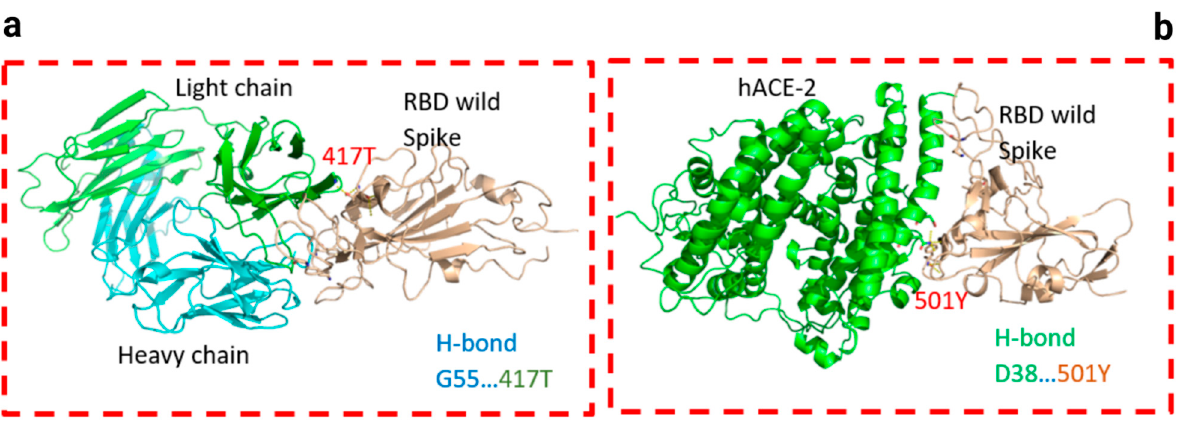
Figure 6. Docking structures of the interaction of P.1 mutant SARS-CoV-2 S-RBD protein in complex with a potent neutralizing CV30 antibody ( a ) and hACE2 ( b ). The dashed line indicates the hydrogen bond.